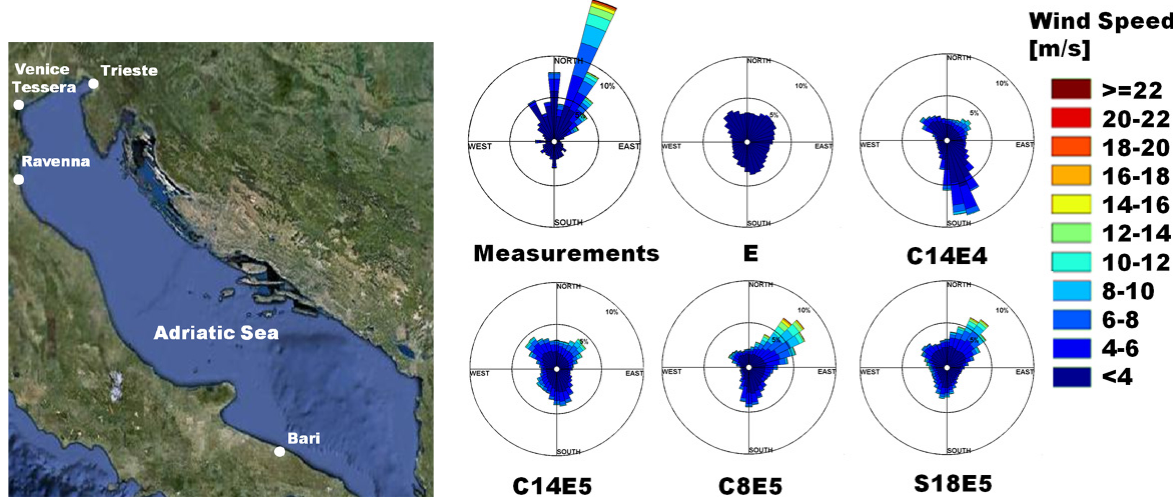
Figure 1. Location of wind stations (left panel). In the right panels, the wind direction distribution (direction of provenience) for E, C14E4, C14E5, C8E5, S18E5 and the measured datasets for the Trieste Station are shown for the reference period